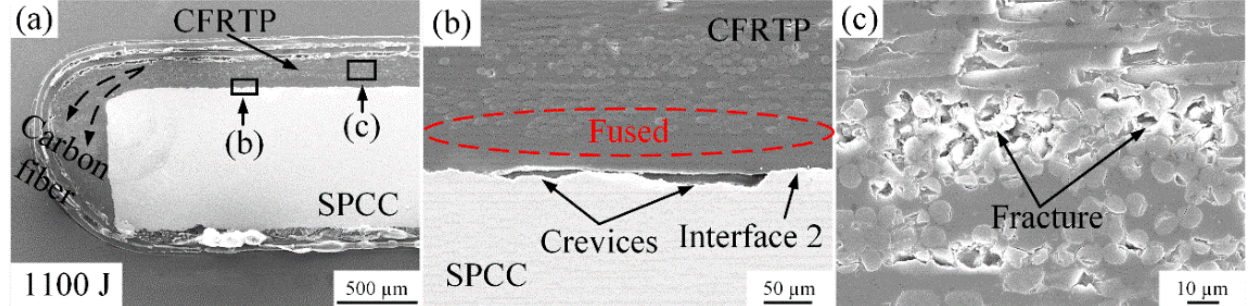
Figure 10. Microstructure of the joint cross-section at the 1100 J energy: ( a ) carbon fibers squeezed out phenomenon; ( b ) situation of interface 1 and 2; ( c ) fractures on carbon fiber.